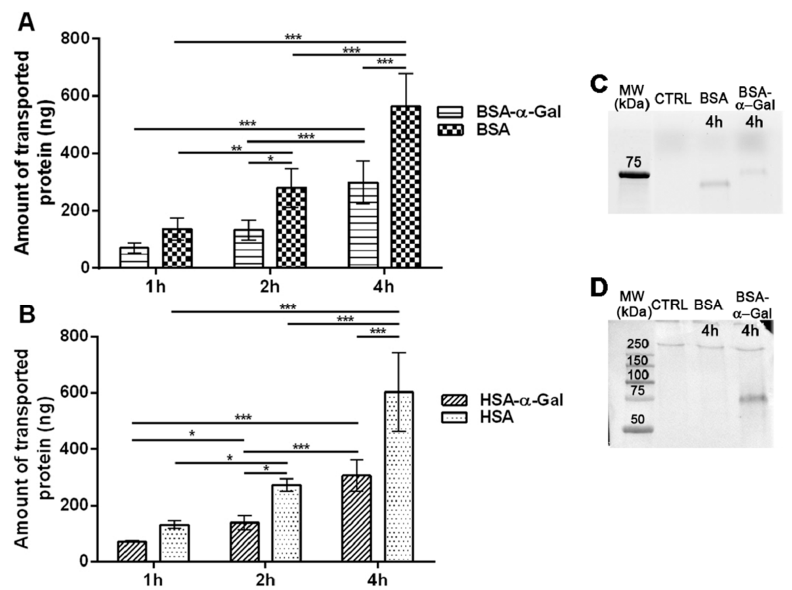
Figure 2. Transport of proteins carrying α -Gal through the intestinal Caco-2 monolayer. ( A ) Time dependent transcytosis of BSA- α -Gal and BSA, n = 4, and ( B ) human serum albumin (HSA) carrying α -Gal (HSA- α -Gal) and HSA, n = 4. * p < 0.05, ** p < 0.01 and *** p < 0.001 analyzed by two-way ANOVA with Bonferroni’s post hoc test; ( C ) fluorescent detection of BSA- α -Gal and BSA in Caco-2 lysates resolved on sodium dodecyl sulfate polyacrylamide gel electrophoresis (SDS PAGE) gel; ( D ) immunoblot detection of the α -Gal epitope in lysates from Caco-2. MW = Molecular weight markers and CTRL = untreated Caco-2 cells.